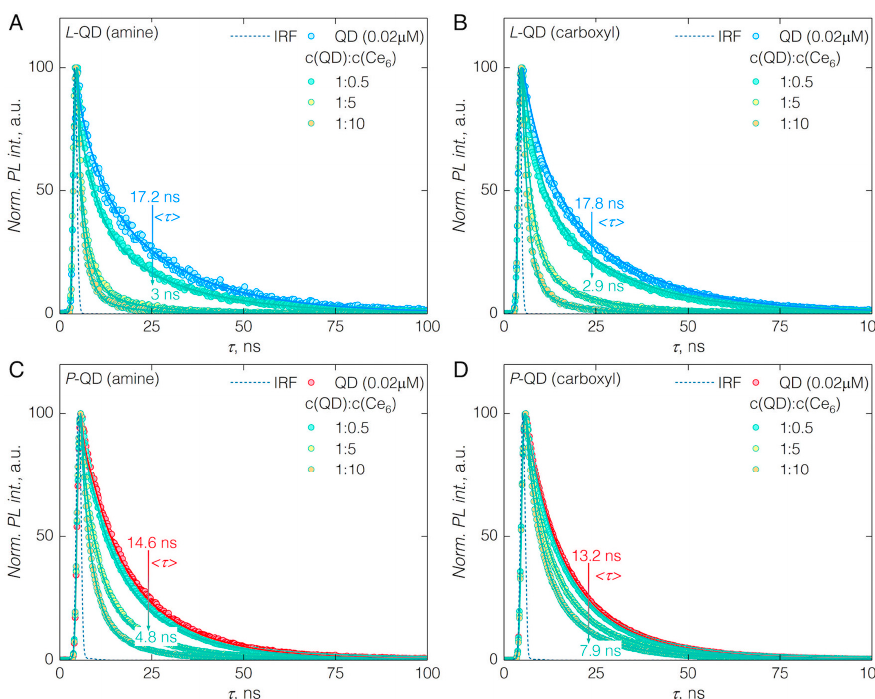
Figure 4. PL decay time ( λ ex = 405 nm; λ em = 605 nm) of pure QDs and in the QD-Ce 6 complex at QD:Ce 6 molar concentration ratio of 1:0.5, 1:5 and 1:10. ( A ) L -QD(amine)-Ce 6 ; ( B ) L -QD(carboxyl)-Ce 6 ; ( C ) P -QD(amine)-Ce 6 ; ( D ) P -QD(carboxyl)-Ce 6 . Amplitude-weighted lifetimes were obtained from tri-exponential fits of the PL decay curves. Instrument response function (IRF) is shown for each